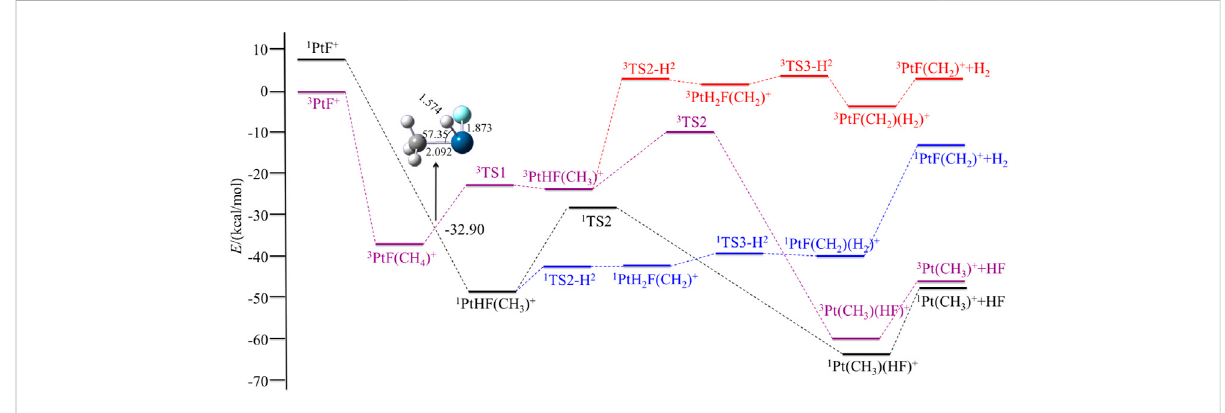
FIGURE 1 Potential energy surfaces of the reaction PtF + + CH 4 in the low- and high-spin states. The structure is the minimum energy crossing point (MECP).